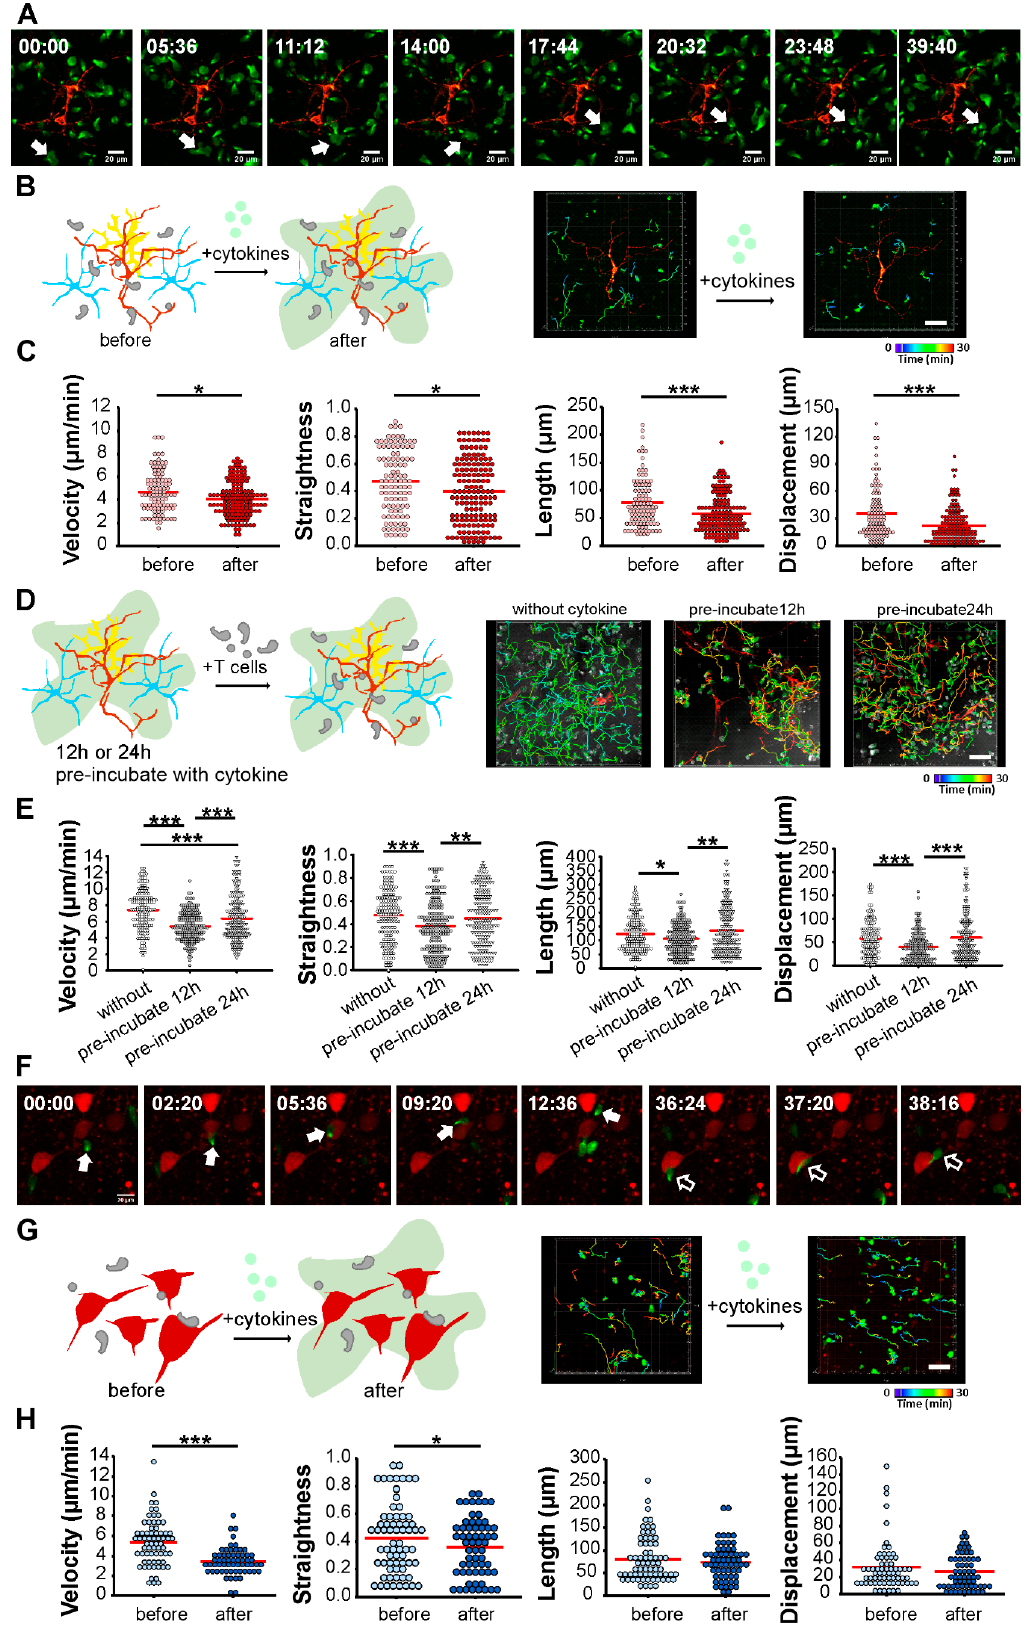
Figure 3. T cell mobility is altered under inflammatory conditions in both in vitro culture and ex vivo brain slices. ( A ) Confocal images of CD8cre- τ GFP T cells (green) migrating on a neuronal